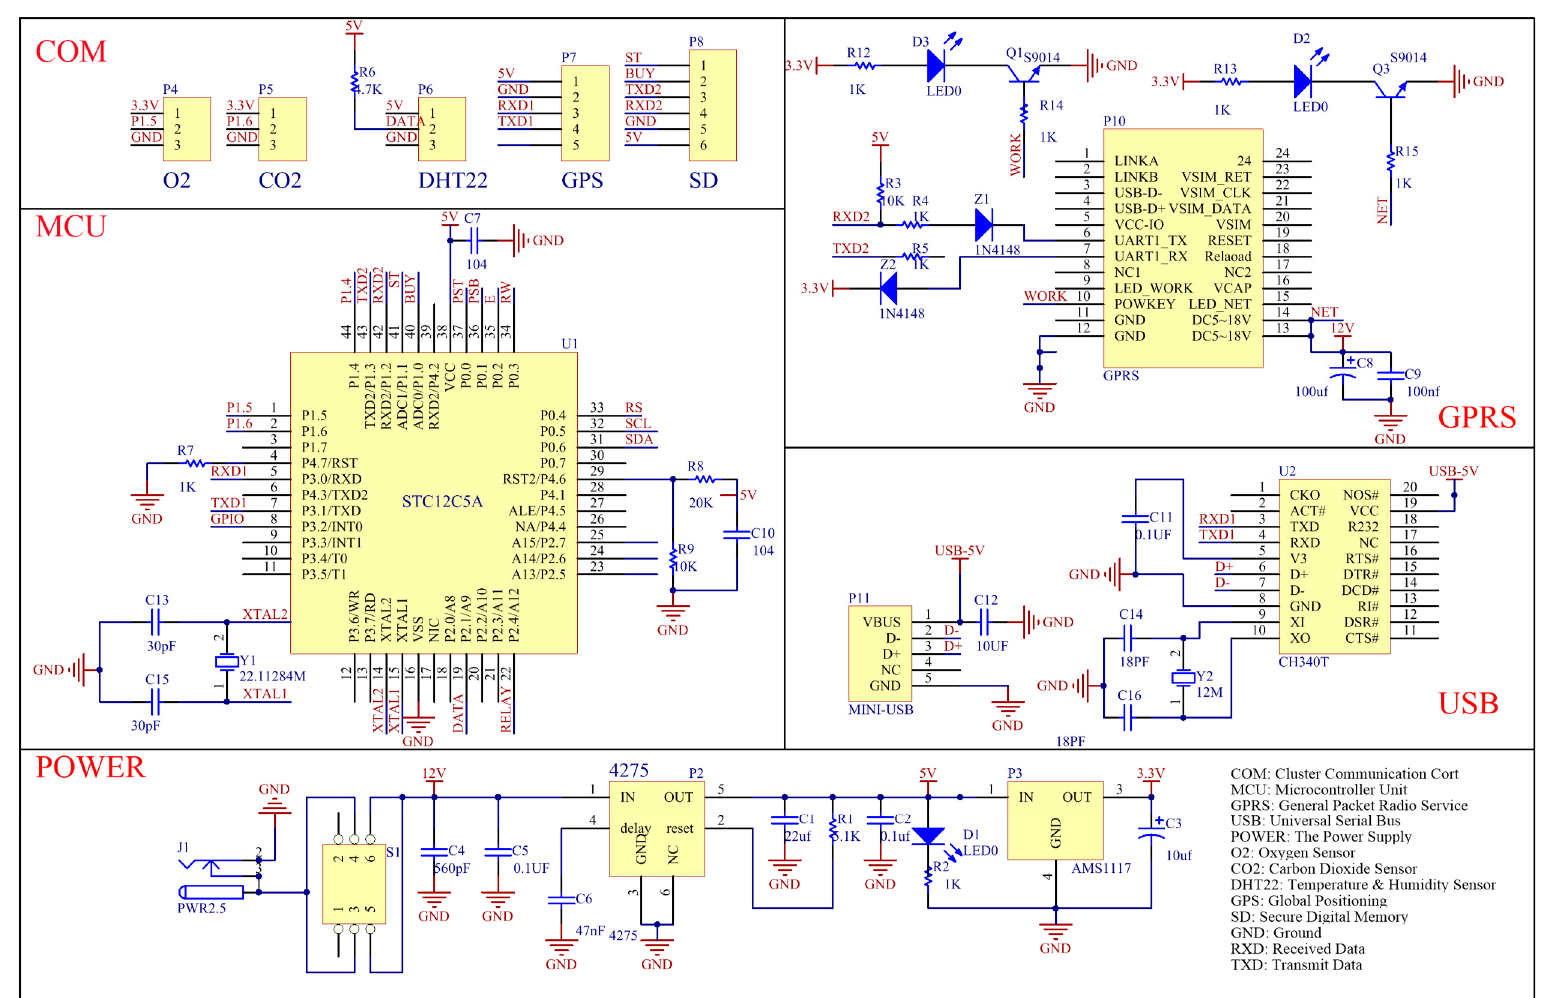
Figure 4. Circuit of the multi-parameter information acquisition and fusion device.